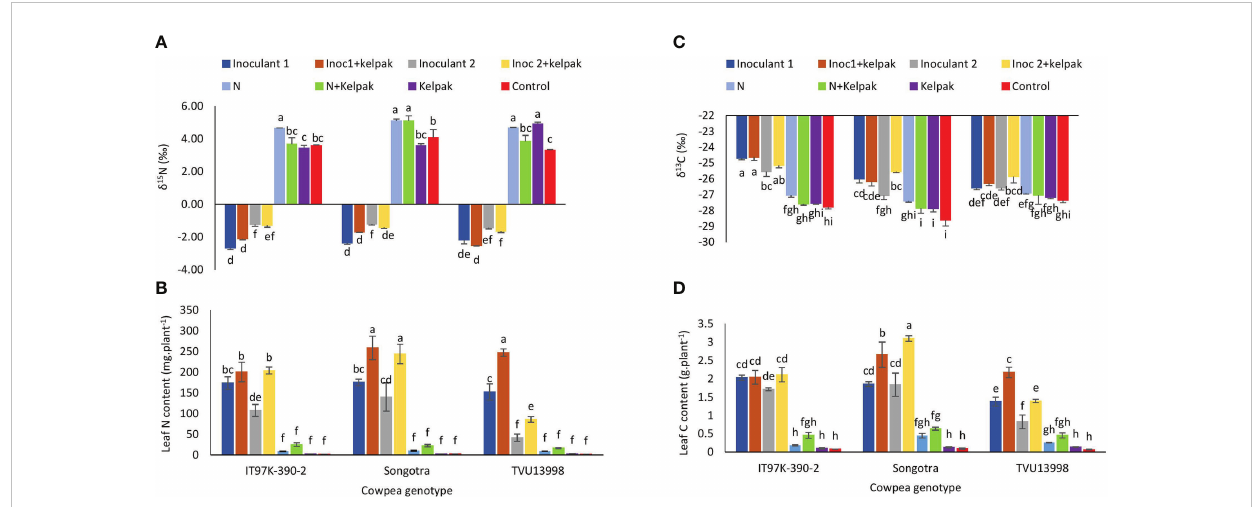
FIGURE 2 Interactive effect of genotype x treatment on d 15 N (A) , leaf N content (B) , leaf d 13 C (C) and leaf C content (D) of three cowpea genotypes, planted under glasshouse conditions. Inoculant 1(Inoc 1) = B . yuanmingense strain CB756 (commercial inoculant), Inoculant 2 (Inoc 2) = Bradyrhizobium sp. strain TUTVUSA (closely related to B . daqingense ), control = no inoculant and no kelpak, N= 5mM KNO 3, control= no inoculation and no kelpak. Vertical lines on bars represent S.E. Bars followed by dissimilar letters are signi fi cant at ***p ≤